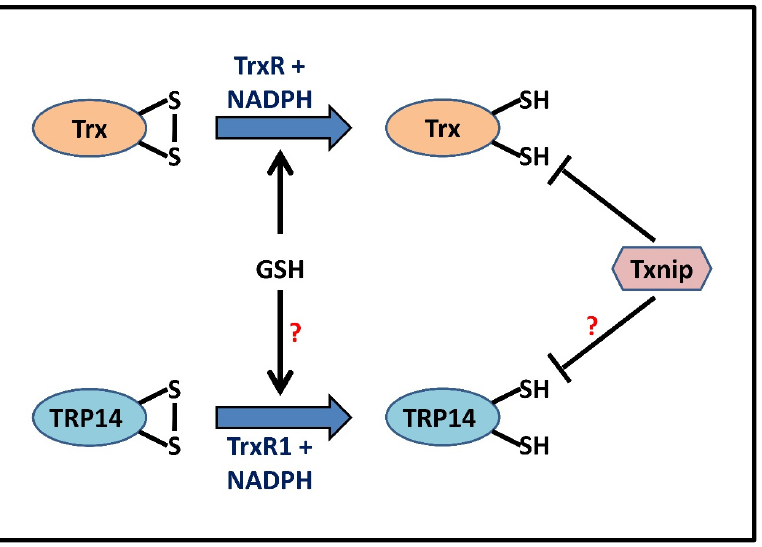
Figure 4. Proposed schematic representation predicting parallels between GSH and redoxin sys- tems. Oxidized Trx (Trx-S 2 ) is reduced back to its vicinal dithiol (Trx-(SH) 2 ) form by TrxR, utilizing